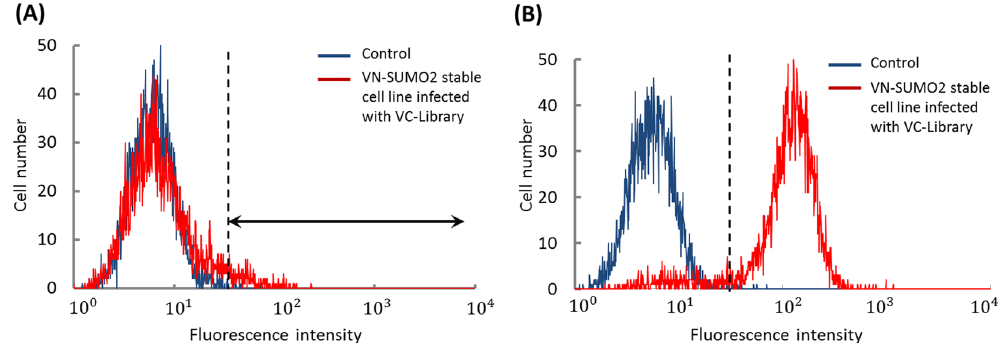
Figure 4. FACS isolation of the fluorescent cells. Fluorescence intensities of the non-infected VN-SUMO2 stable cell lines (control cells) and the VN-SUMO2 stable cell lines that were infected with VC-library DNAs (probe-introduced cells) were analyzed by FACS. ( A ) Comparison of control cells with the probe-introduced cells before FACS sorting. The region indicated with an arrow includes the cells that have higher fluorescence intensities than control cells. ( B ) Comparison of control cells with the probe-induced cells after FACS sorting. The target fluorescent cells were repeatedly incubated and sorted by a FACS four times. The data show the fluorescence intensity of the cells after the last